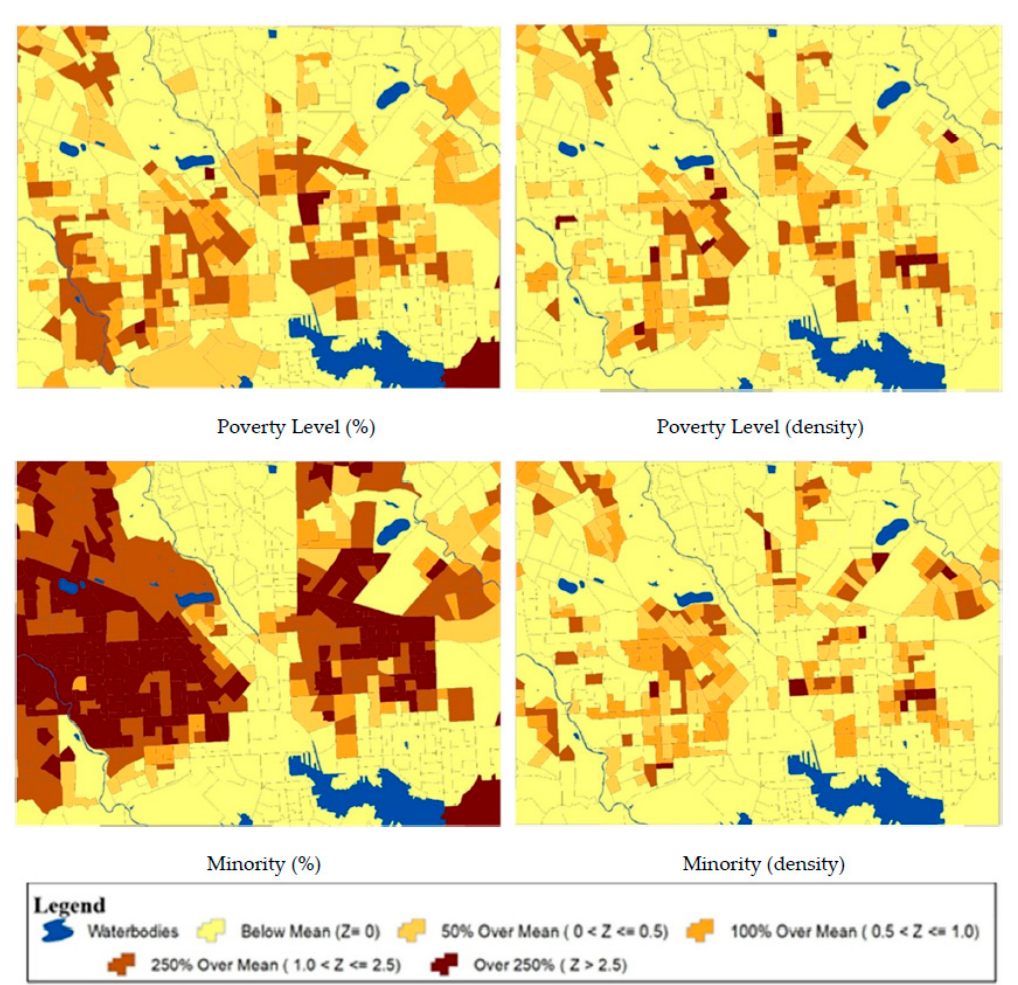
Figure 3. Comparison of Environmental Justice Indicators z-scores.